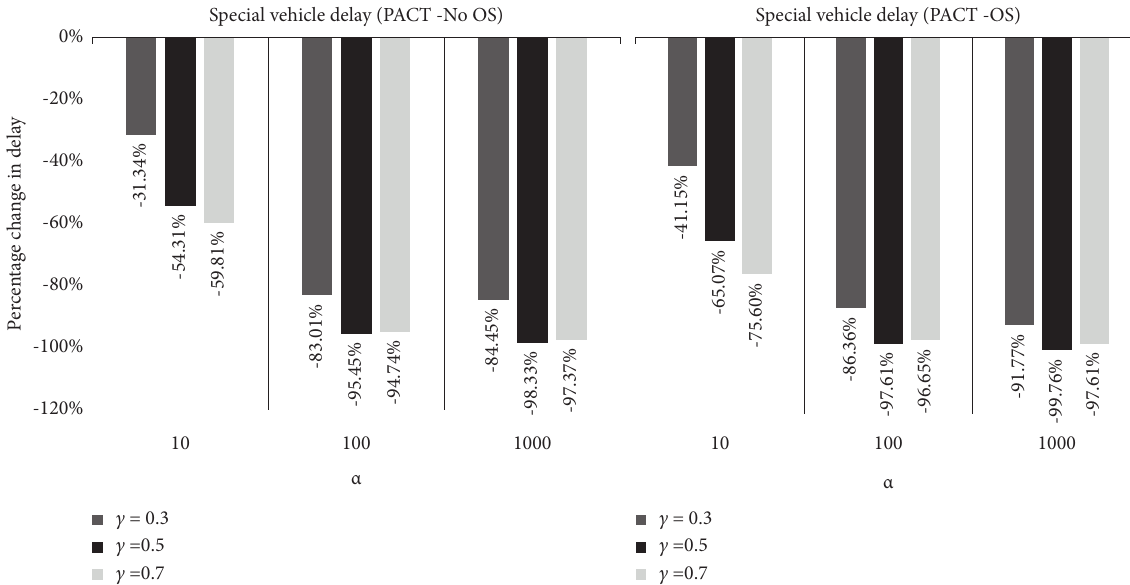
Figure 17: Percentage changes in delays compared to various α and c